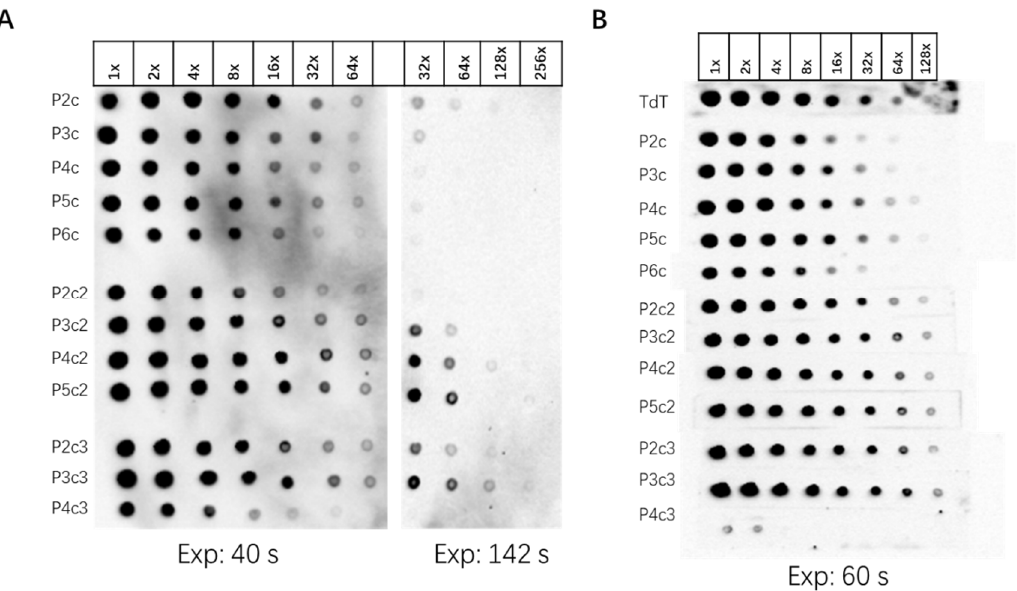
Figure 3. Sensitivity test of labeled probes in dot blot analysis. ( A ) Detection of labeled probes using biotin ‐ detection kit. The labeled probe was purified with a gel filtration column, diluted as indicated on top, added onto the N+ nylon membrane, and UV ‐ crosslinked. Here, 1× represents the 10 pmoles probe. ( B ) Detection of hybridized membrane using biotin ‐ detection kit. Oligo complementary to probe sequences was diluted as indicated on top, added onto the N+ nylon membrane stripe, UV ‐ crosslinked, and hybridized with each probe (indicated to the left) individually. TdT, a TdT ‐ labeled probe used as a control. Here, 1× represents 10 pmoles oligo. Exp, exposure time.